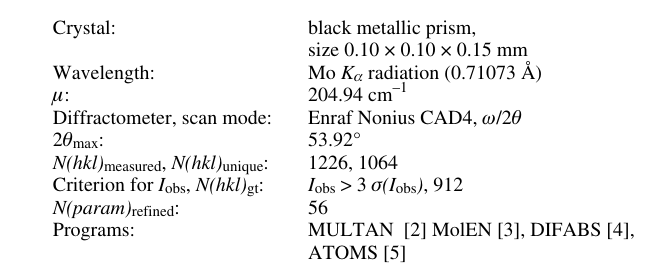
Table 1. Data collection and handling. Crystal: